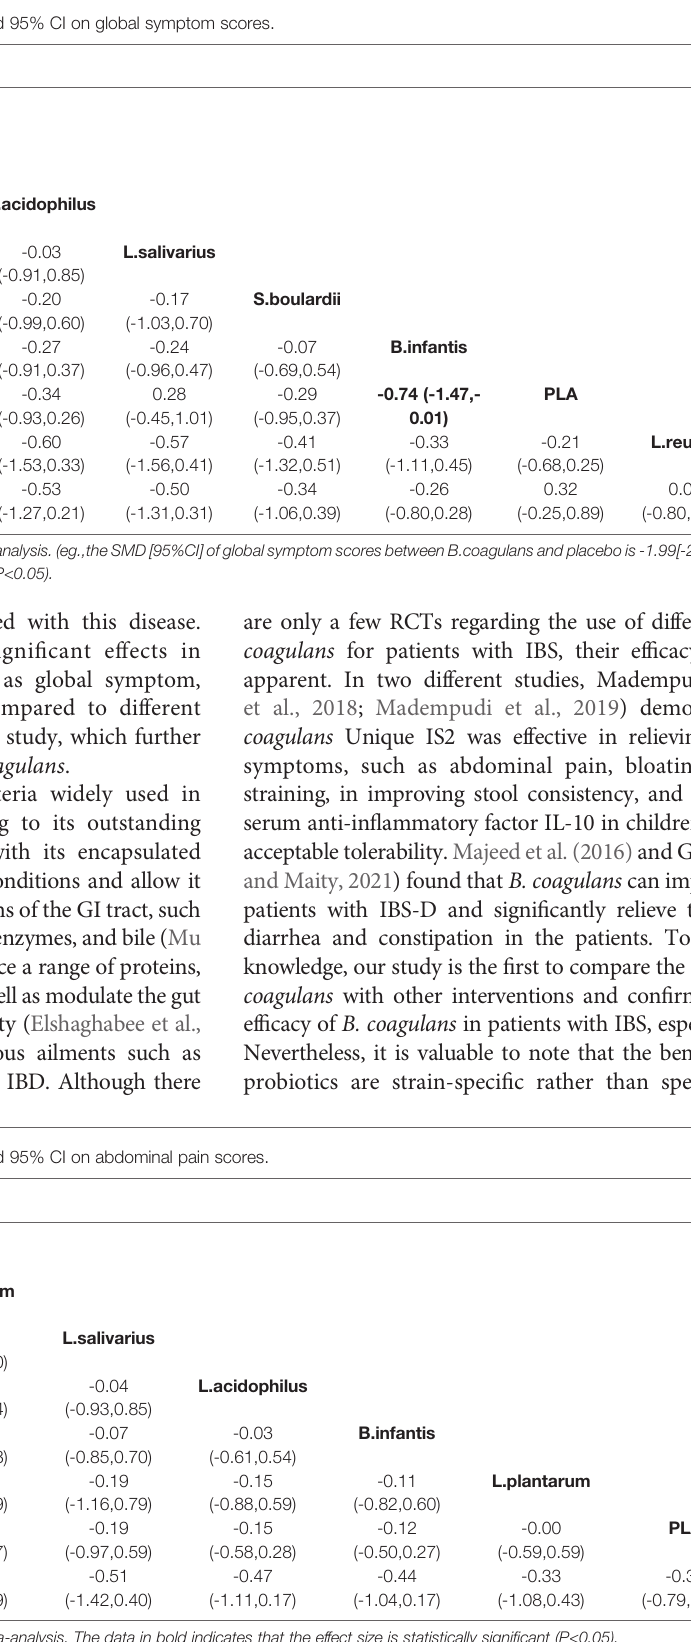
Lower left triangle refers to the SMD from the network meta-analysis. The data in bold indicates that the effect size is statistically signi fi cant